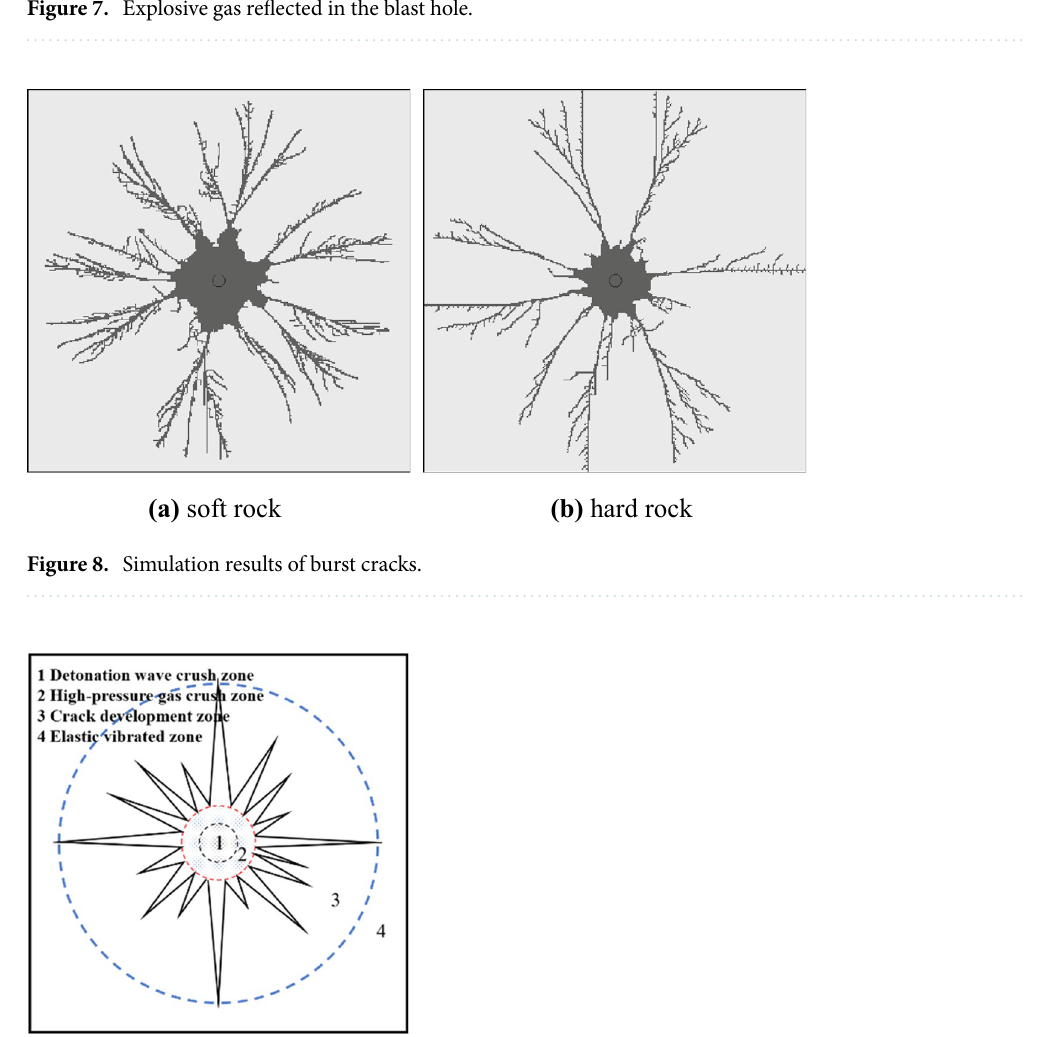
Figure 7. Explosive gas reflected in the blast hole.